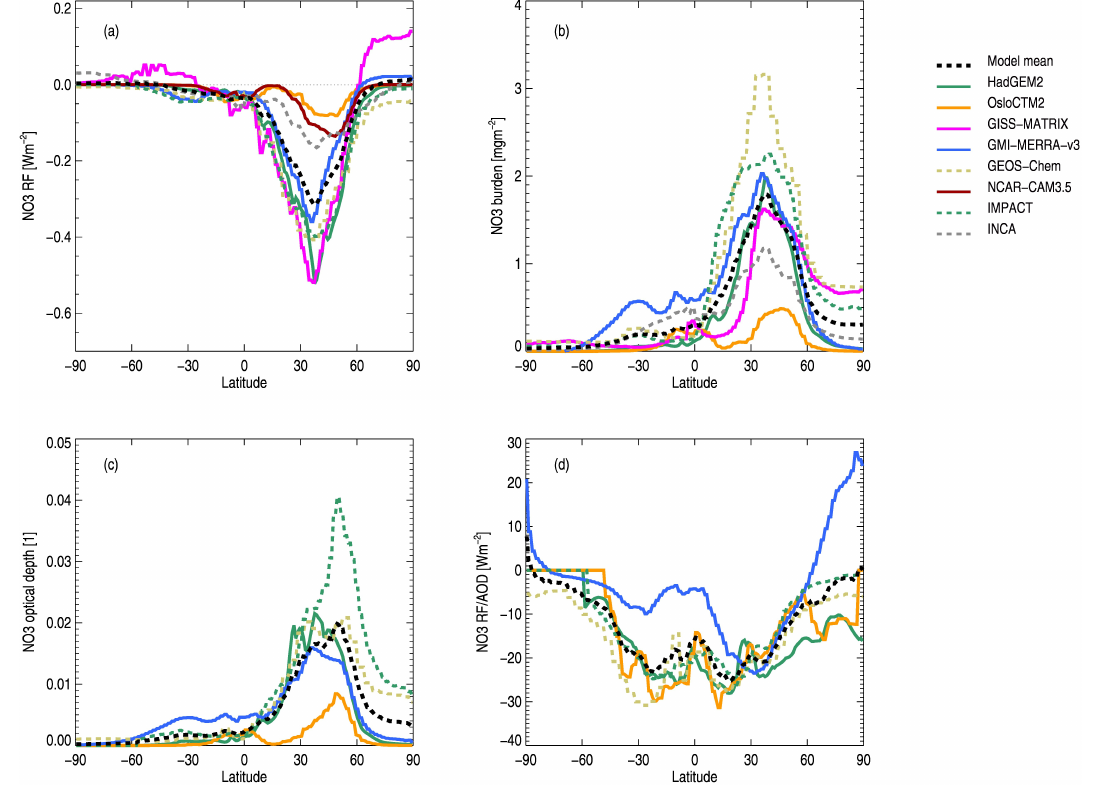
Fig. 12. Zonal mean NO 3 RF (a) , burden (b) , AOD at 550nm (c) , NRF(A) (d) .